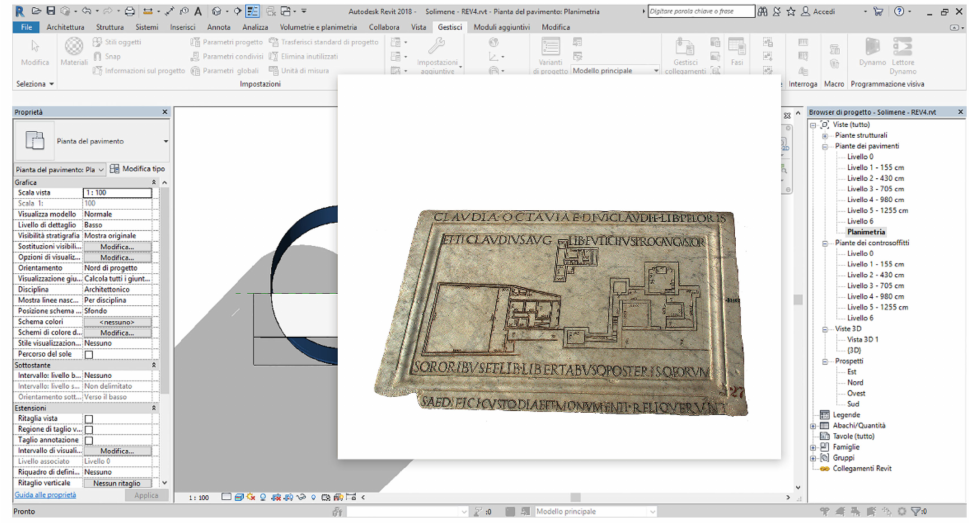
Figure 9. The association of the information with the 3D